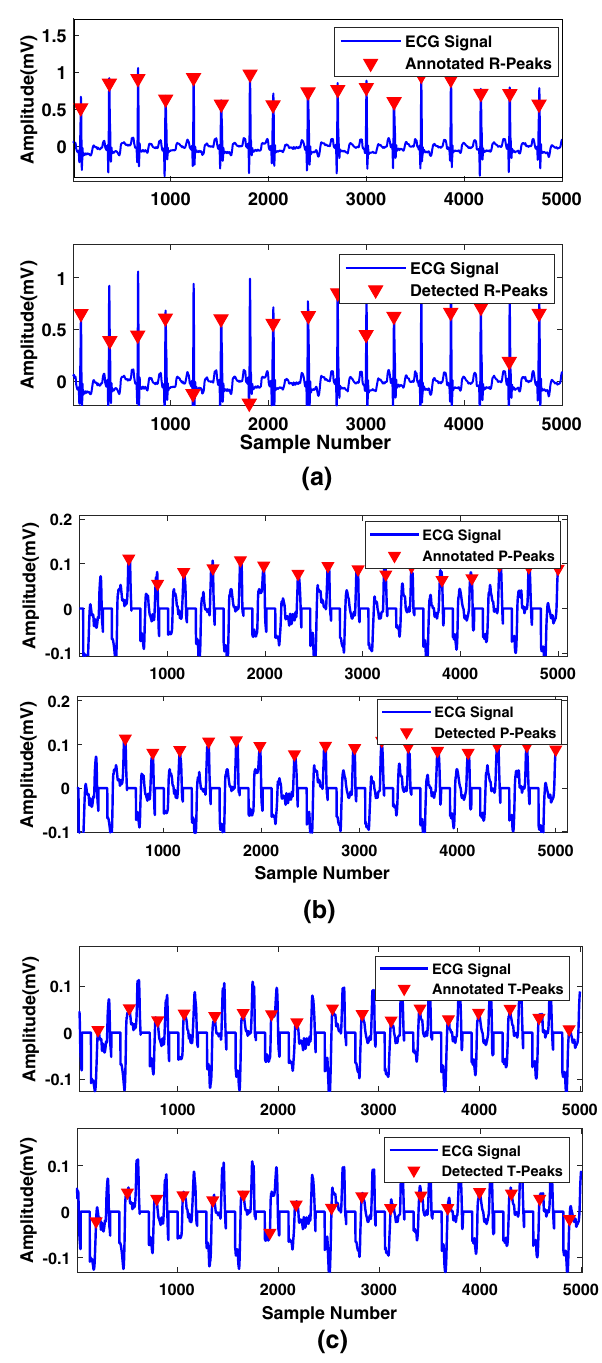
Figure 6. ( a ) Actual annotations for the R-peak in ECG record 200 m, ( b ) Actual annotations for the P-peak in ECG record 103 m, and ( c ) Actual annotations for the T-peak in ECG record 103m and the detected T-peaks after applying the